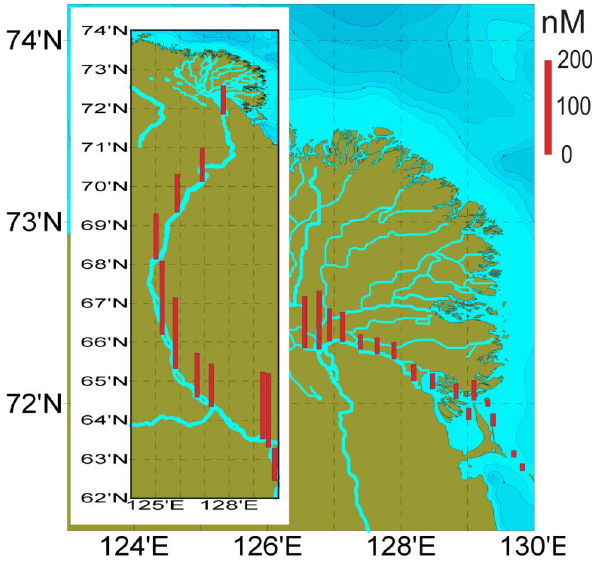
Fig. 11. Distribution of dissolved CH 4 (nM) in the Lena River wa- ter, September